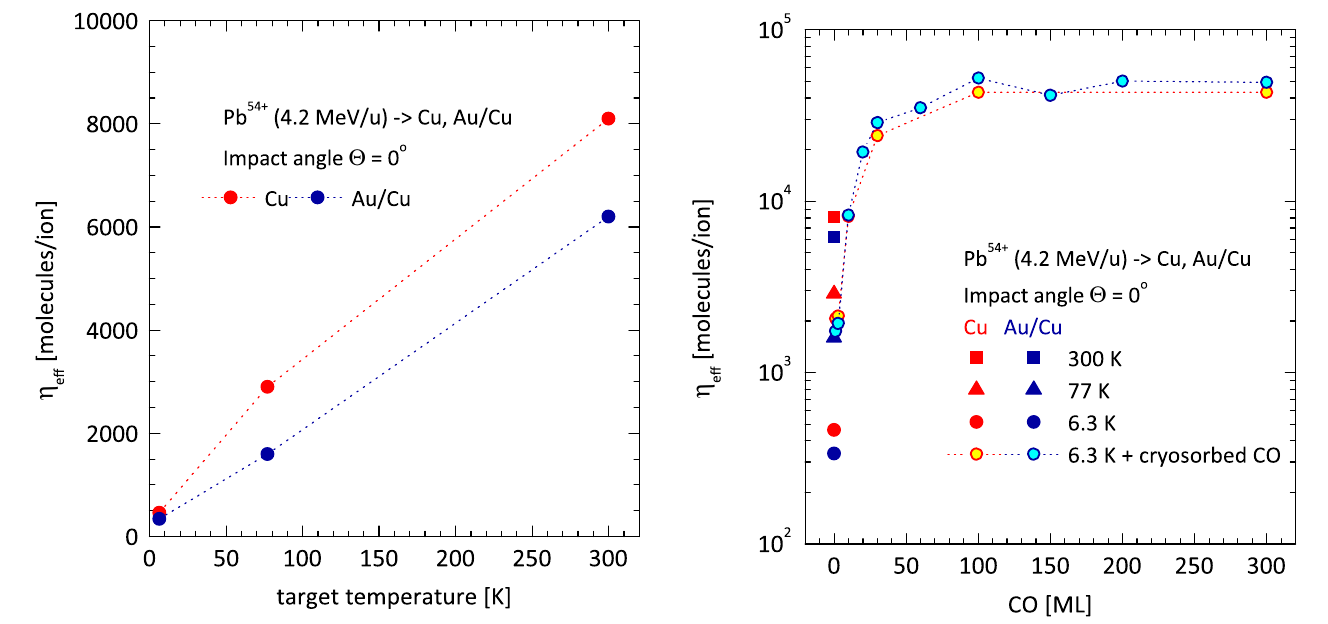
FIG. 5. Temperature dependence of the heavy-ion-induced de- sorption yield of bare and gold-coated surfaces bombarded under (cid:1) ¼ 0 (cid:2) with 4 : 2 MeV = u Pb 54 þ